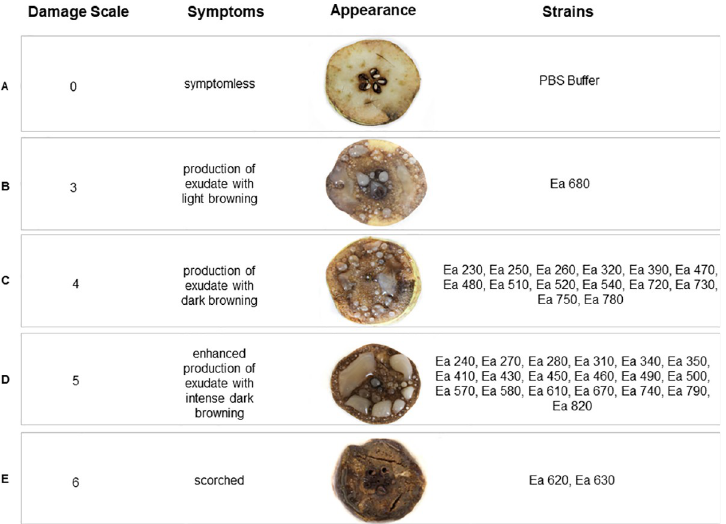
Fig 4. Virulence assay results. Symptoms observed in immature pear slices 7 days after infection with Erwinia amylovora isolates, were categorized according a damage scale adapted from Schwarczinger et al. [69]. Positive control (C+): Type Strain LMG 2024. Negative control (C-): PBS Buffer.